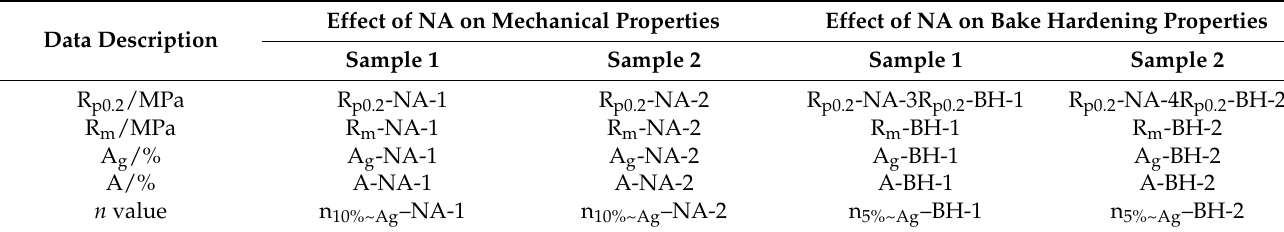
Table 2. Data obtained at each time point along one